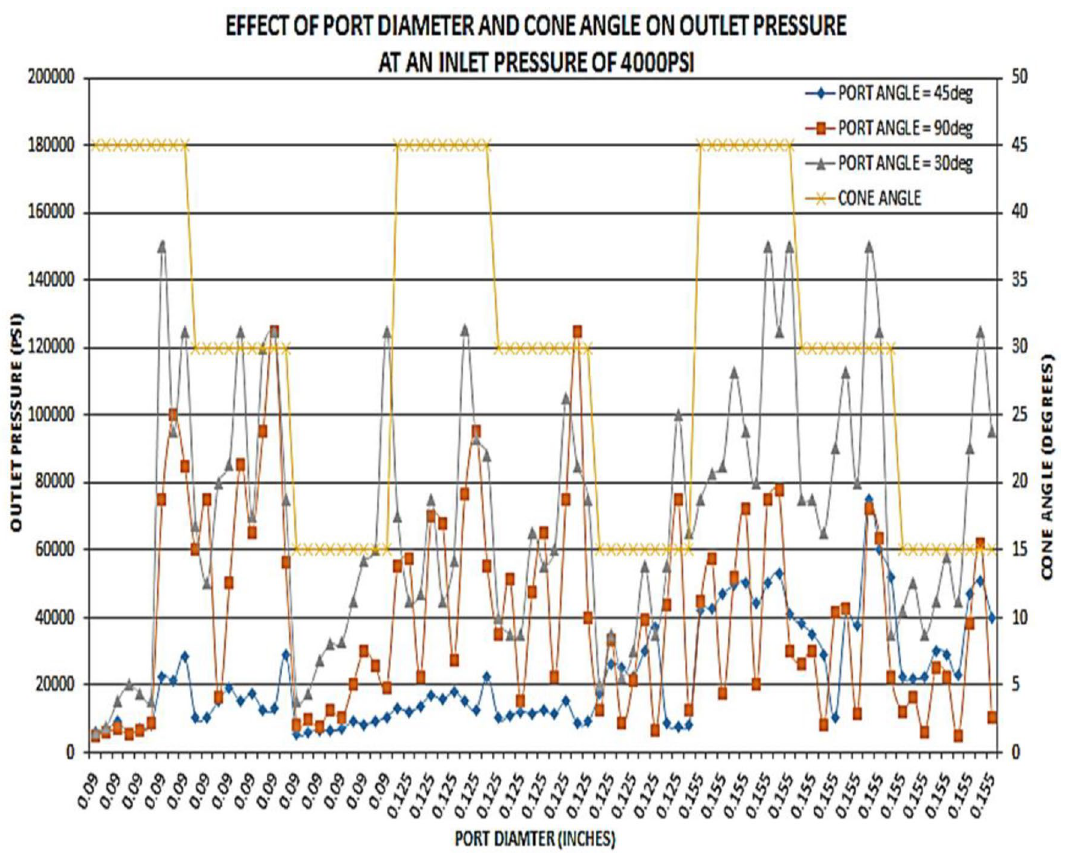
Fig. 8 Effect of port diameter and cone angle on outlet pressure at an inlet pressure of 4000